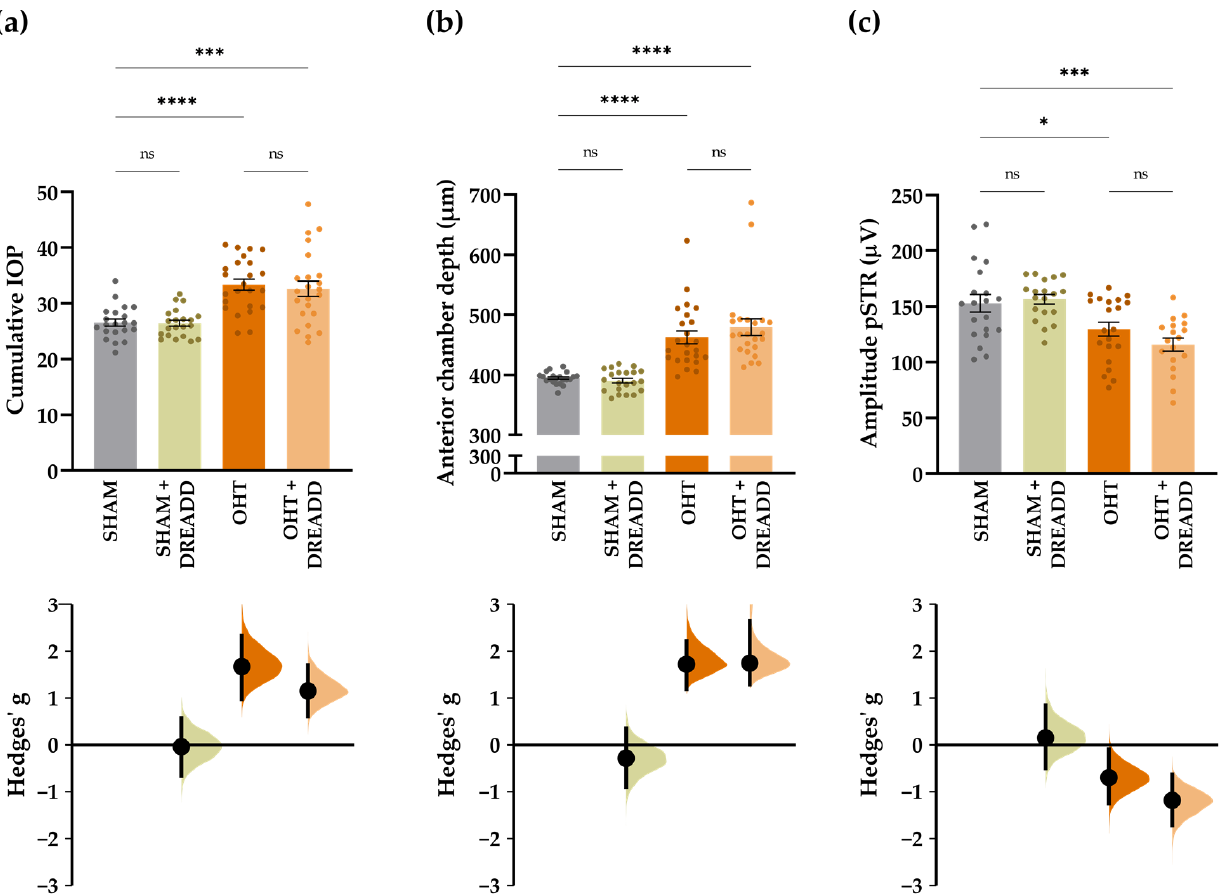
Figure 9. One-way ANOVA and estimation statistics (Hedges’ g) on different read-outs to probe glaucoma induction and progression ( n = 18–24 mice). ( a ) Cumulative IOP, defined as the area under the curve of IOP measured at 2, 3 and 4 weeks post injury, was elevated upon OHT induction—i.e., in “OHT” and “OHT + DREADD mice”—and unaltered in “SHAM + DREADD” mice as compared with “SHAM” controls. ( b ) Similarly, anterior chamber depth was elevated five weeks after OHT induction, yet not upon DREADD stimulation alone as compared with “SHAM” controls. ( c ) “SHAM + DREADD” mice showed a similar pSTR response as “SHAM” mice, whereas this re- sponse was significantly lower in “OHT” and “OHT + DREADD” mice as compared with “SHAM” mice. The pSTR response was identical in “OHT” and “OHT + DREADD” mice, revealing that DREADD stimulation of the superior colliculus did not rescue RGC functionality in mild glaucoma- tous mice. Mice with a pupil diameter < 1 mm were excluded. Key: ns = non-significant, * p ≤ 0.05, *** p ≤ 0.001 and **** p ≤ 0.0001. Mean values and estimation statistics are listed in Supplementary File S6, Tables S1 and